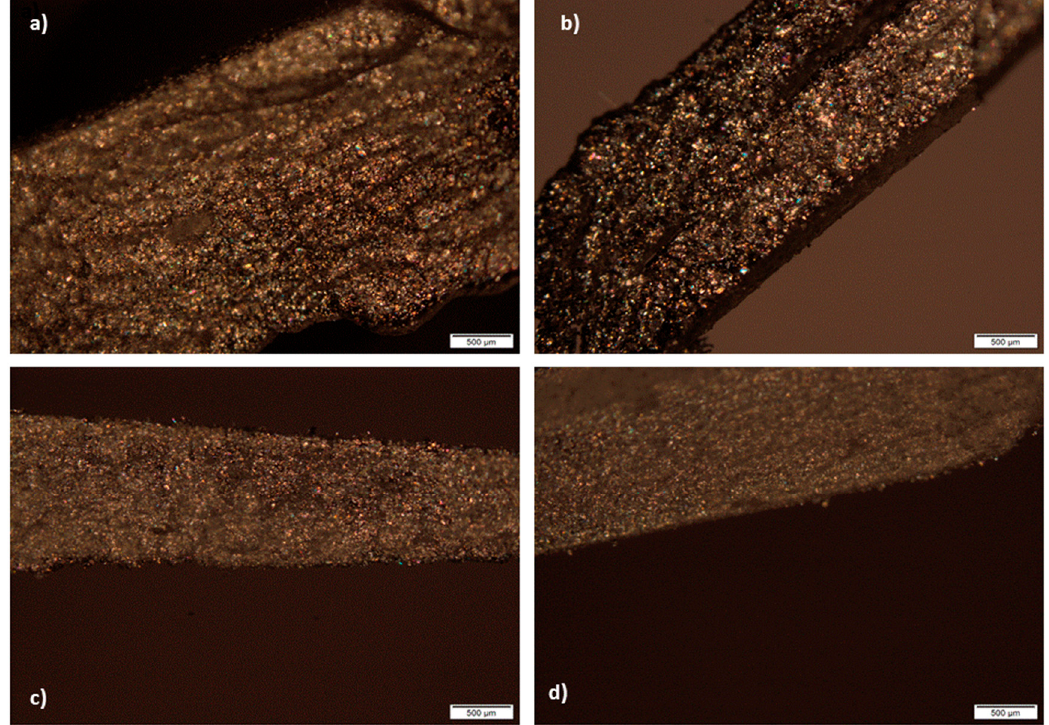
Figure 7. Cross-sectional views of tablets: ( a ) A1; ( b ) A2; ( c ) A3; ( d ) A4 formulations.